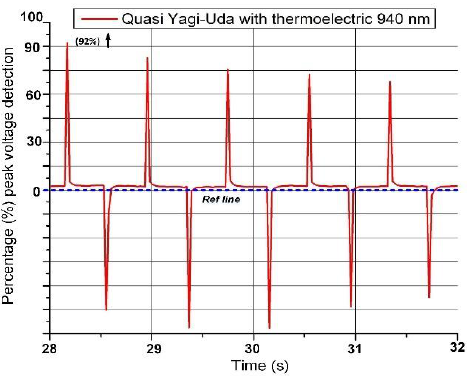
Figure 10. Influence of 940-nm laser pulses on quasi-Yagi–Uda nanoantenna design in terms of voltage response.